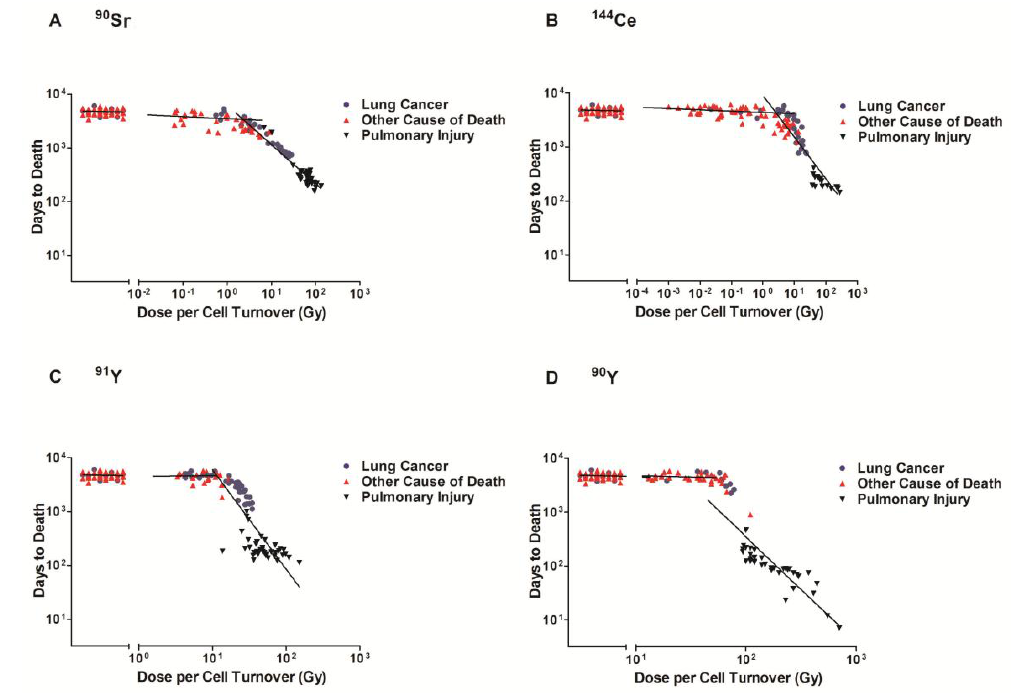
Figure 1. Cause of death of Beagle dogs exposed to radionuclides. The cause of death of dogs exposed to 90 Sr ( A ), 144 Ce ( B ), 91 Y ( C ), and 90 Y ( D ) in fused aluminosilicate particles was measured as a function of average dose per cell turnover. Transformed dose/cell turnover were plotted against days to death following inhalation. The cause of death is represented by a data point for each individual dog. Lung Cancer ( ) Other Causes of Death ( (cid:78) ) and Pulmonary Injury ( (cid:72) ), Lines represent three linear regression analysis: control, area with limited life shortening (not significantly different than control) and significant life shortening ( p < 0.05). At high doses early deaths were all related to pulmonary injury, lower doses resulted in longer survival and a high frequency of lung cancer, further lowering of the dose per cell turnover did not produce a significant decrease in life span or an increase in lung